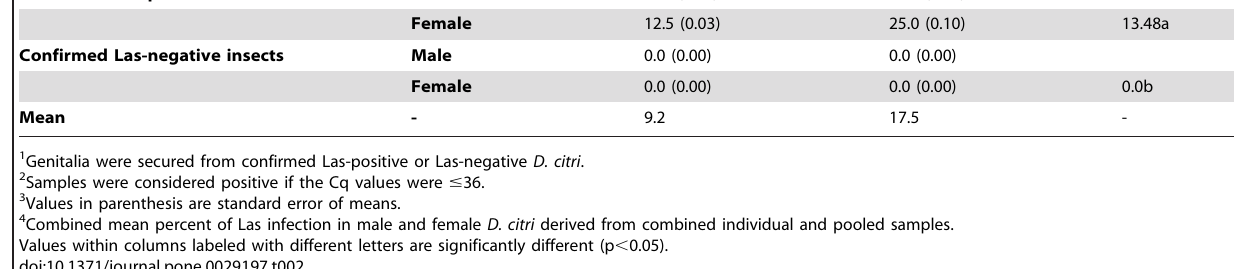
Source of D.citri genitalia 1